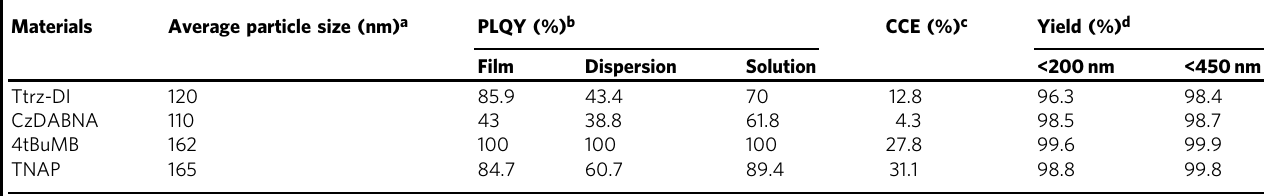
Table 1 Characteristics of the fl uorescent organic